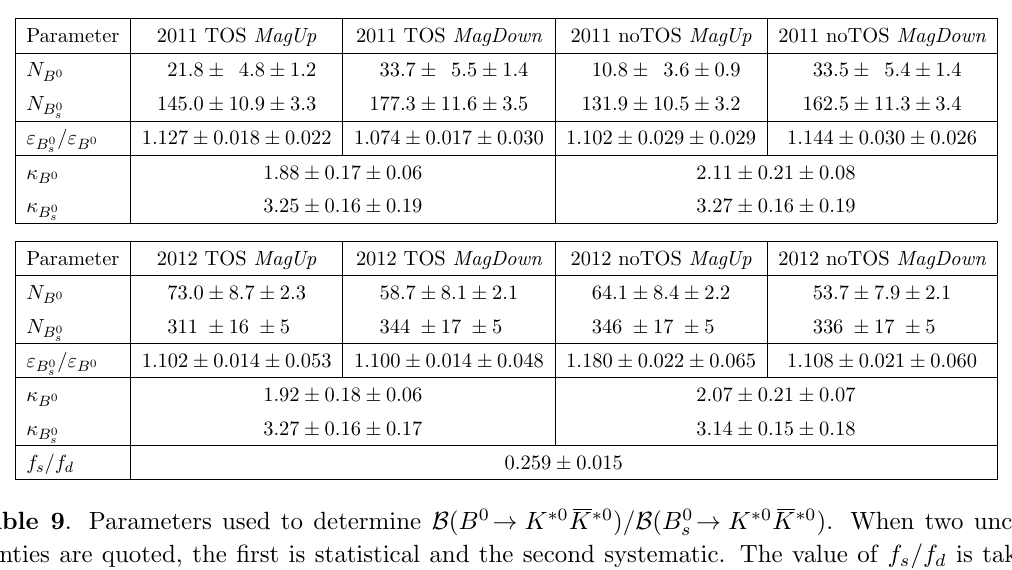
Table 9 . Parameters used to determine tainties are quoted, the (cid:12)rst is statistical and the second systematic. The value of f s =f d is taken from ref.